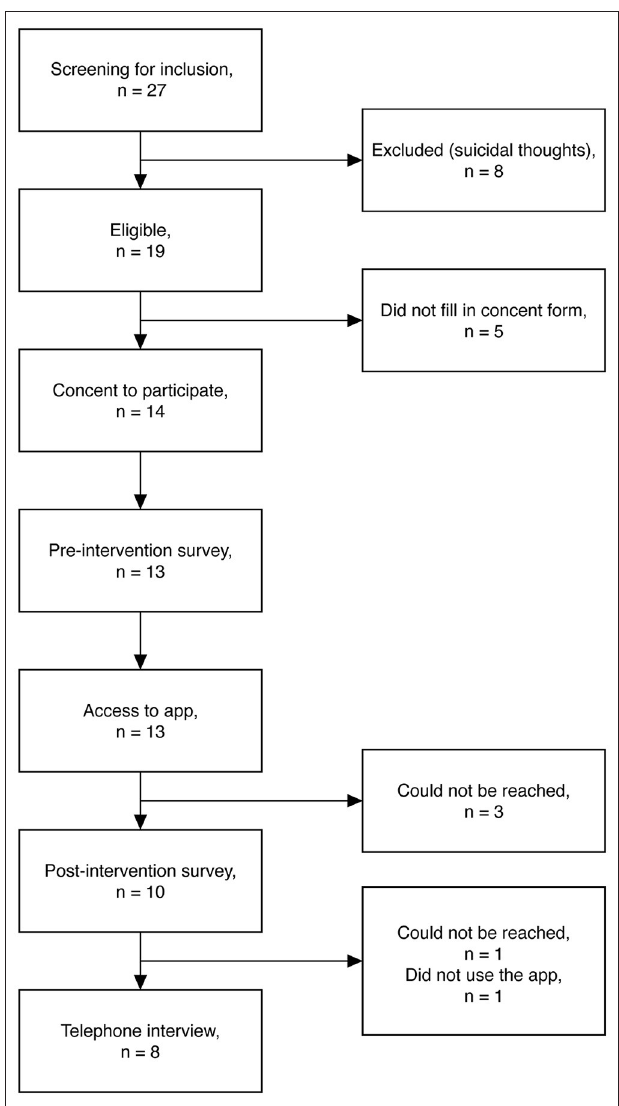
FIGURE 2 | Flowchart over recruitment and pre-post